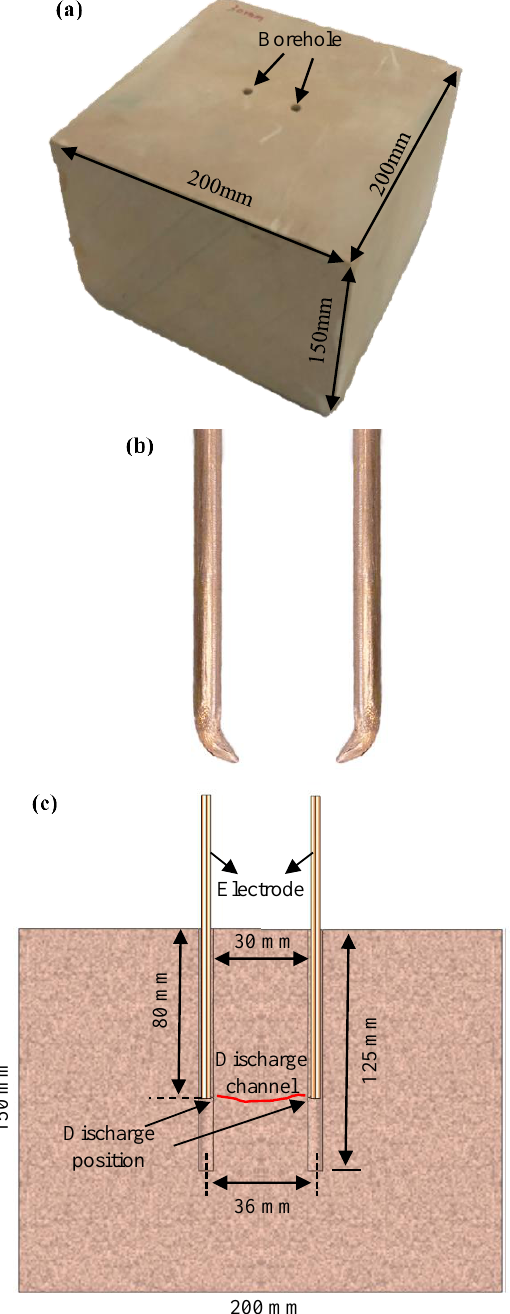
Figure 3. The specimen and electrodes: ( a ) Sandstone specimen; ( b ) Electrodes; ( c ) The layout of electrodes in the specimen.